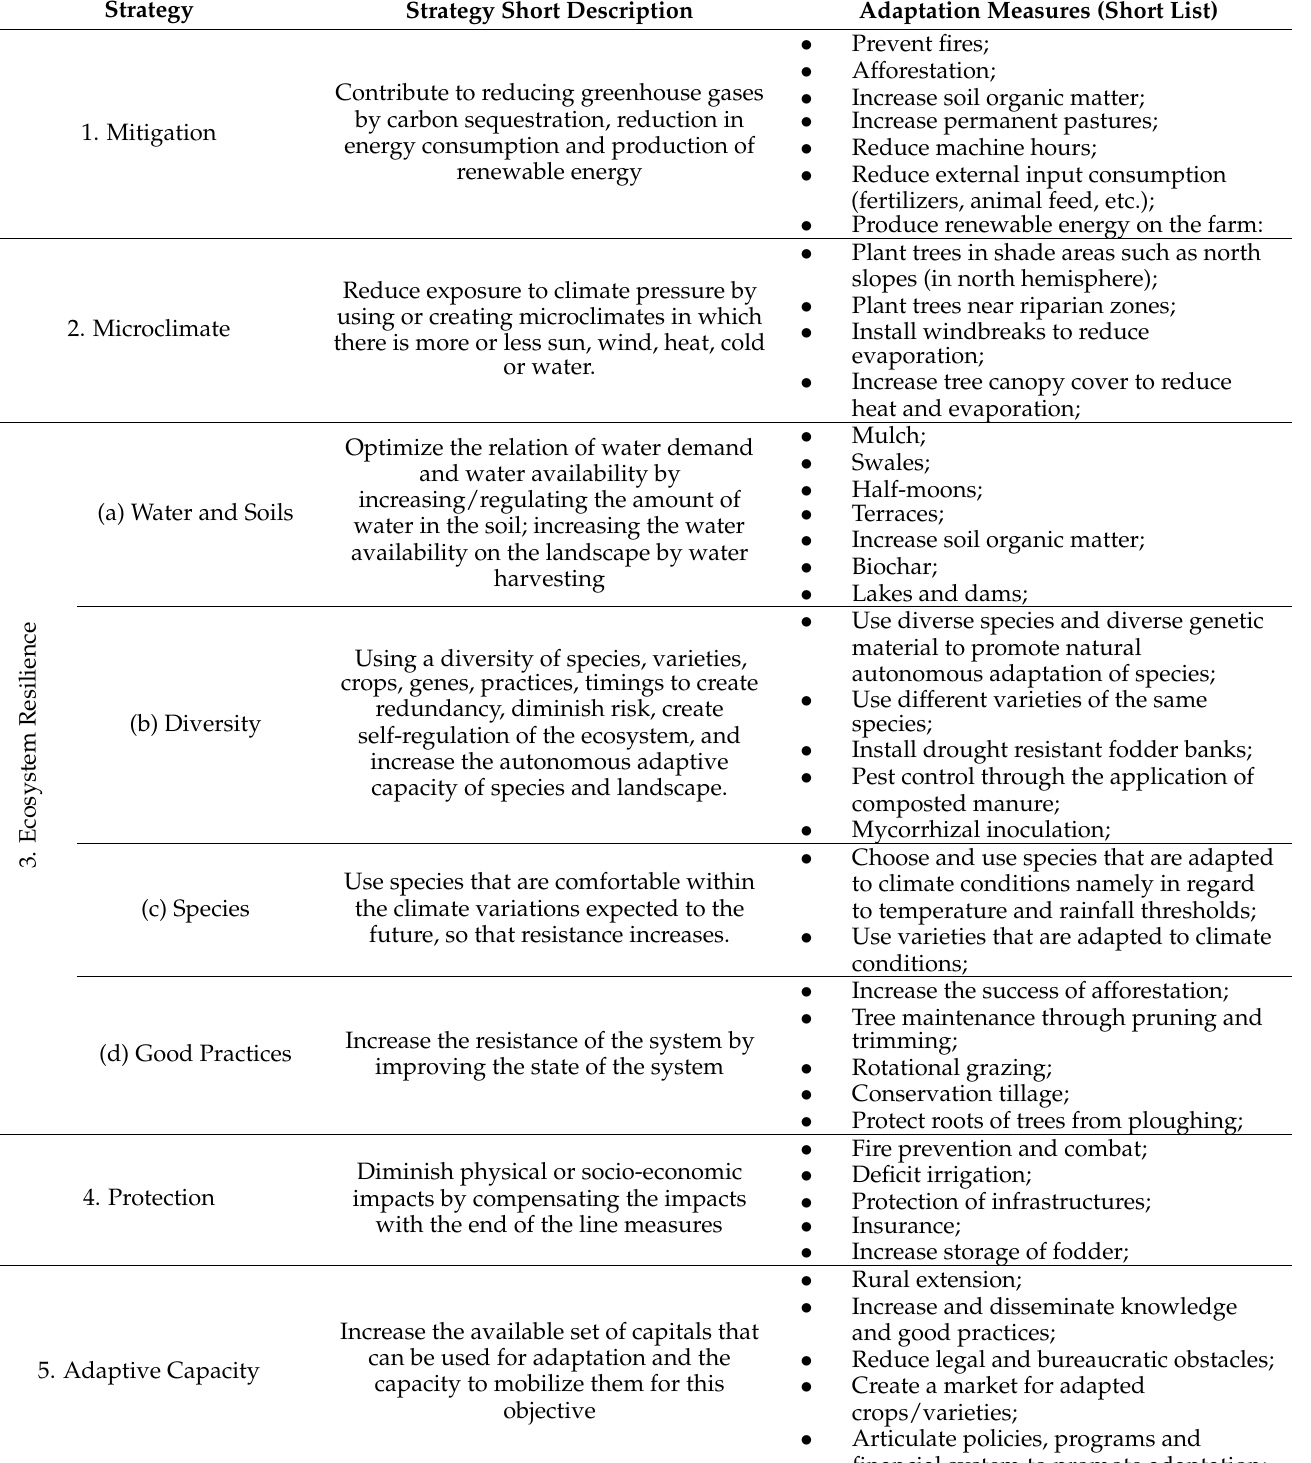
Table 2. Adaptation framework organized by strategies and a short list of adaptation measures that result from interviews, literature review, analysis and organization on cause effect relation with climate